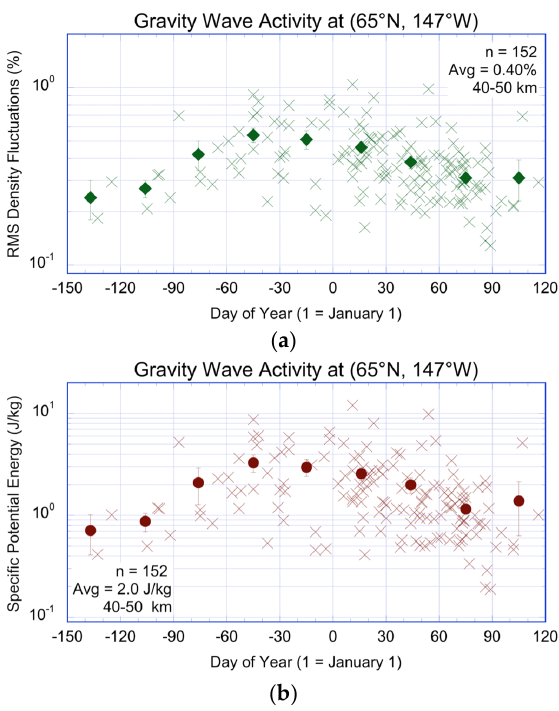
Figure 3. Gravity wave activity measured by Rayleigh LiDAR on 152 nights at Chatanika, Alaska. The data are plotted as the day of year from August to April. The day of year counts from 1 on 1 January, day of year 30 corresponds to 30 January, and day of year -30 corresponds to 1 December. ( a ) RMS density fluctuations with monthly average values as solid diamonds; ( b ) specific potential energies with monthly average values as solid circles.